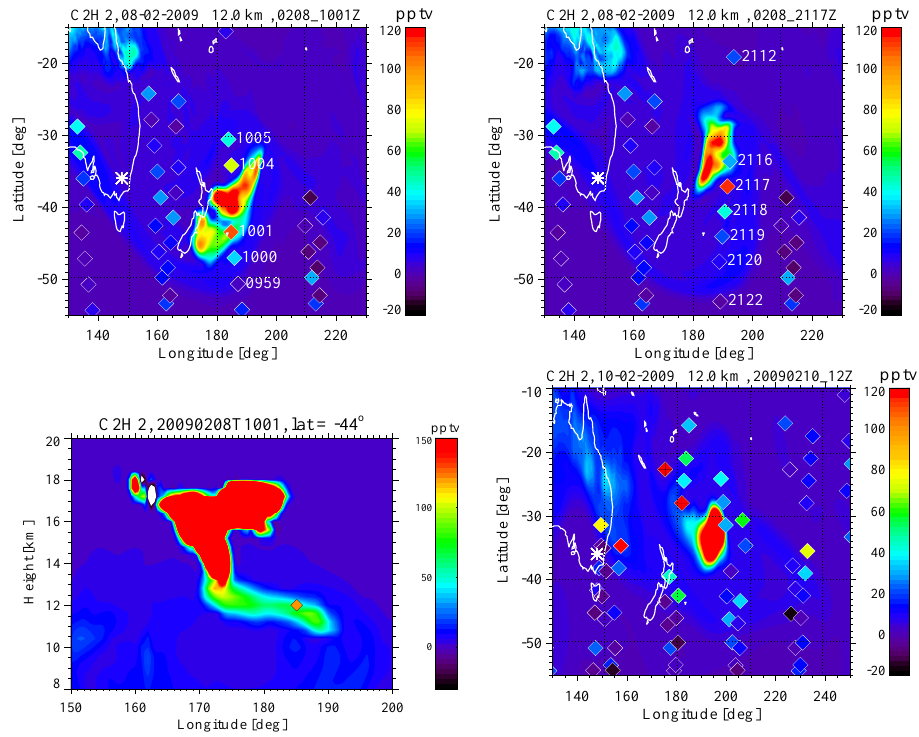
Fig. 10. Top: measured and modelled C 2 H 2 distributions of 8 February at 12km altitude. The model distribution is in original resolution and interpolated to 10:01UT (right) and to 21:17UT (left). The white numbers are the MIPAS measurement times in UT. Bottom left: longitudinal cross section at 44 ◦ S through the model plume from 8 February, 10:01UT, in original resolution. The diamond at 185 ◦ E is the MIPAS measurement from 10:01UT. Bottom right: measured and modelled C 2 H 2 distributions of 10 February at 12km altitude. The model distribution is from 12:00UT and in original